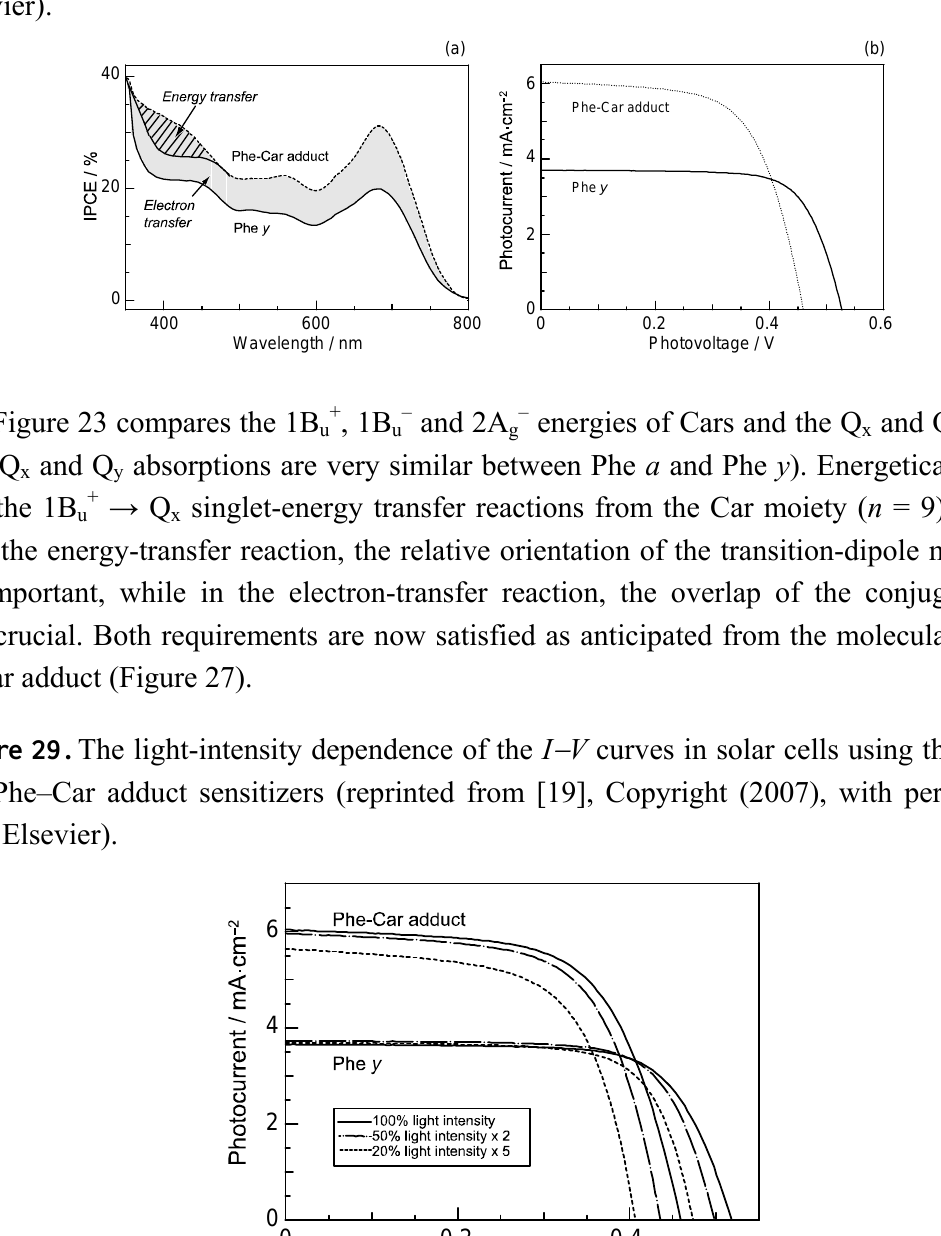
and Phe – Car adduct (reprinted from [19], Copyright (2007), with permission from